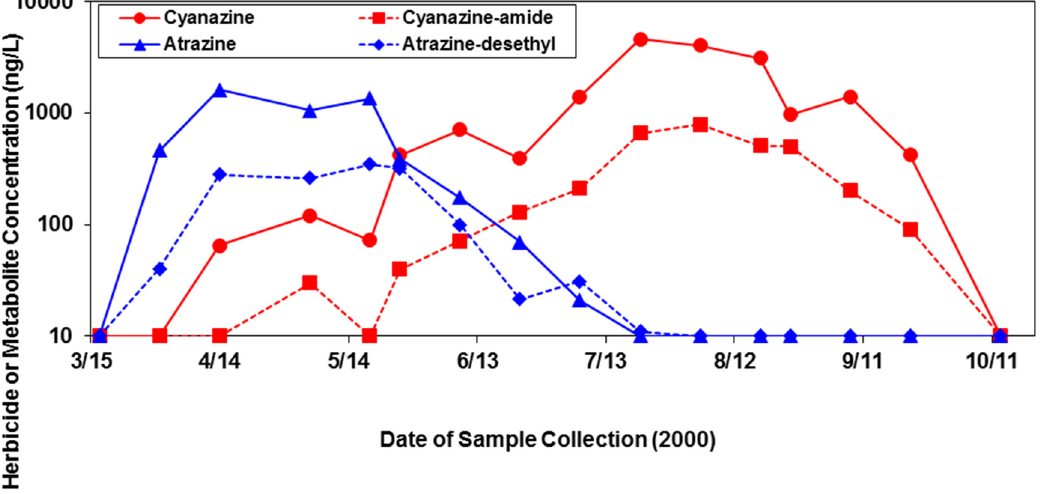
Figure 3. Herbicide and associated metabolite concentrations (ng/L) measured in samples of surface water collected from drainage ditches located on a large commercial farm in Beaufort County, North Carolina during the 2000 growing season.